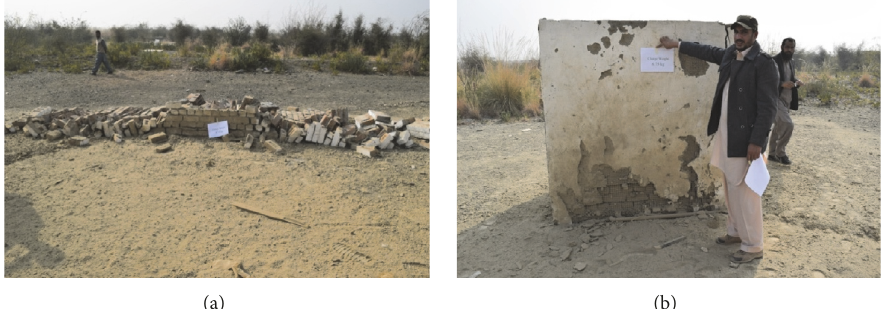
Figure 18: (a) Collapse of unreinforced masonry wall and (b) partially damaged but intact ferrocement